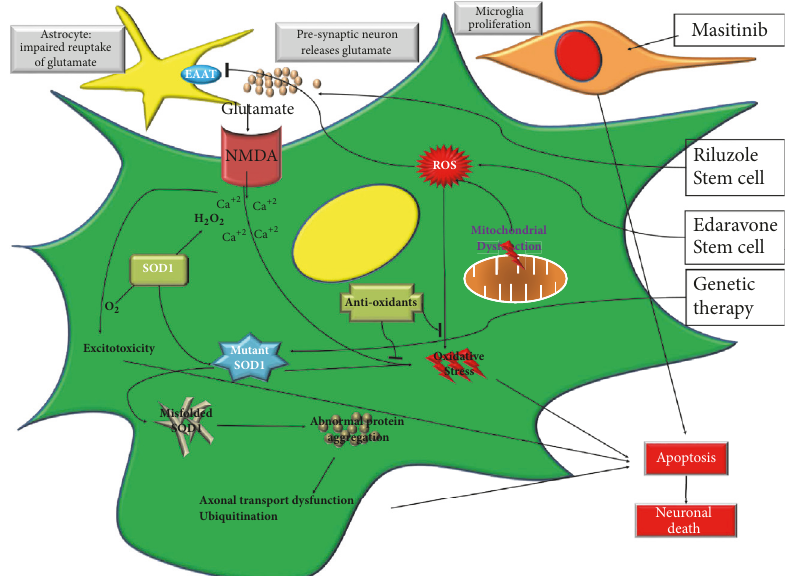
Figure 1: Signaling Pathway in ALS and Mechanism of Action of Current Therapies . The signaling pathway demonstrates that the neuronal cell death that occurs in ALS is triggered by several mechanisms and different therapy may target different mechanisms. Glutamate toxicity is targeted by Riluzole. Oxidative stress is targeted by Edaravone and mircoglia induced inflammation is targeted by masitinib. Stem cell therapy may target many of the above mechanisms. ROS: reactive oxygen species. EAAT2: excitatory amino acid transporter 2. NMDA: N-methyl-d-aspartate. SOD1: superoxide dismutase